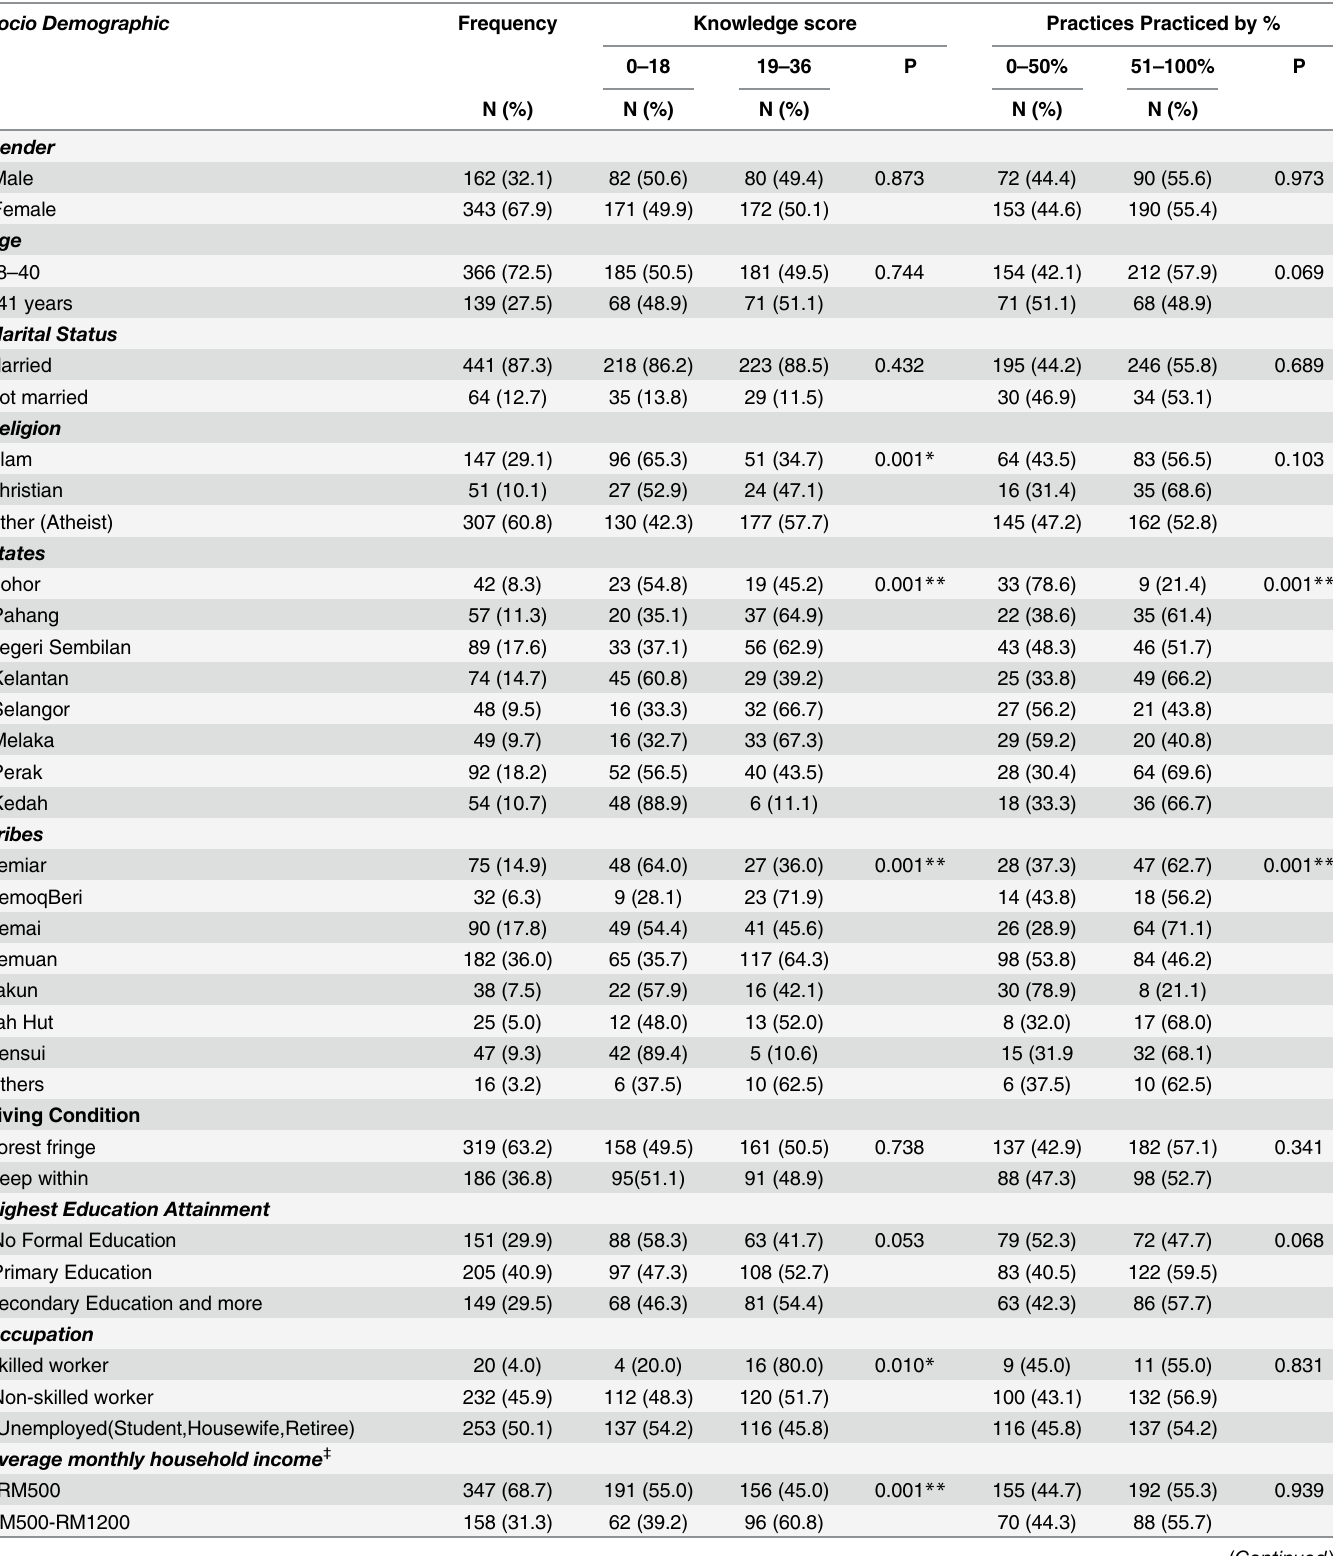
Table 1. Socio demographic characteristics differences of Orang Asli aborigine ’ s knowledge and practices about dengue fever in Peninsular